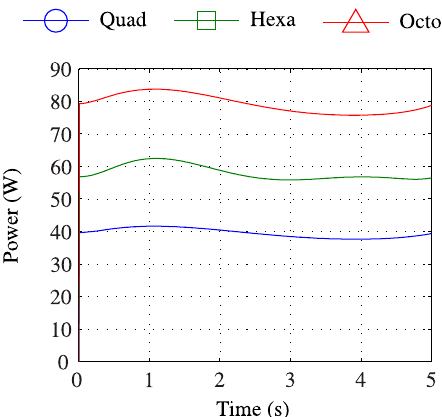
Figure 10. Net power draw from rotors during accurate tracking of the reference trajectory. Table 2. Energy usage for rotors only during accurate tracking of the reference